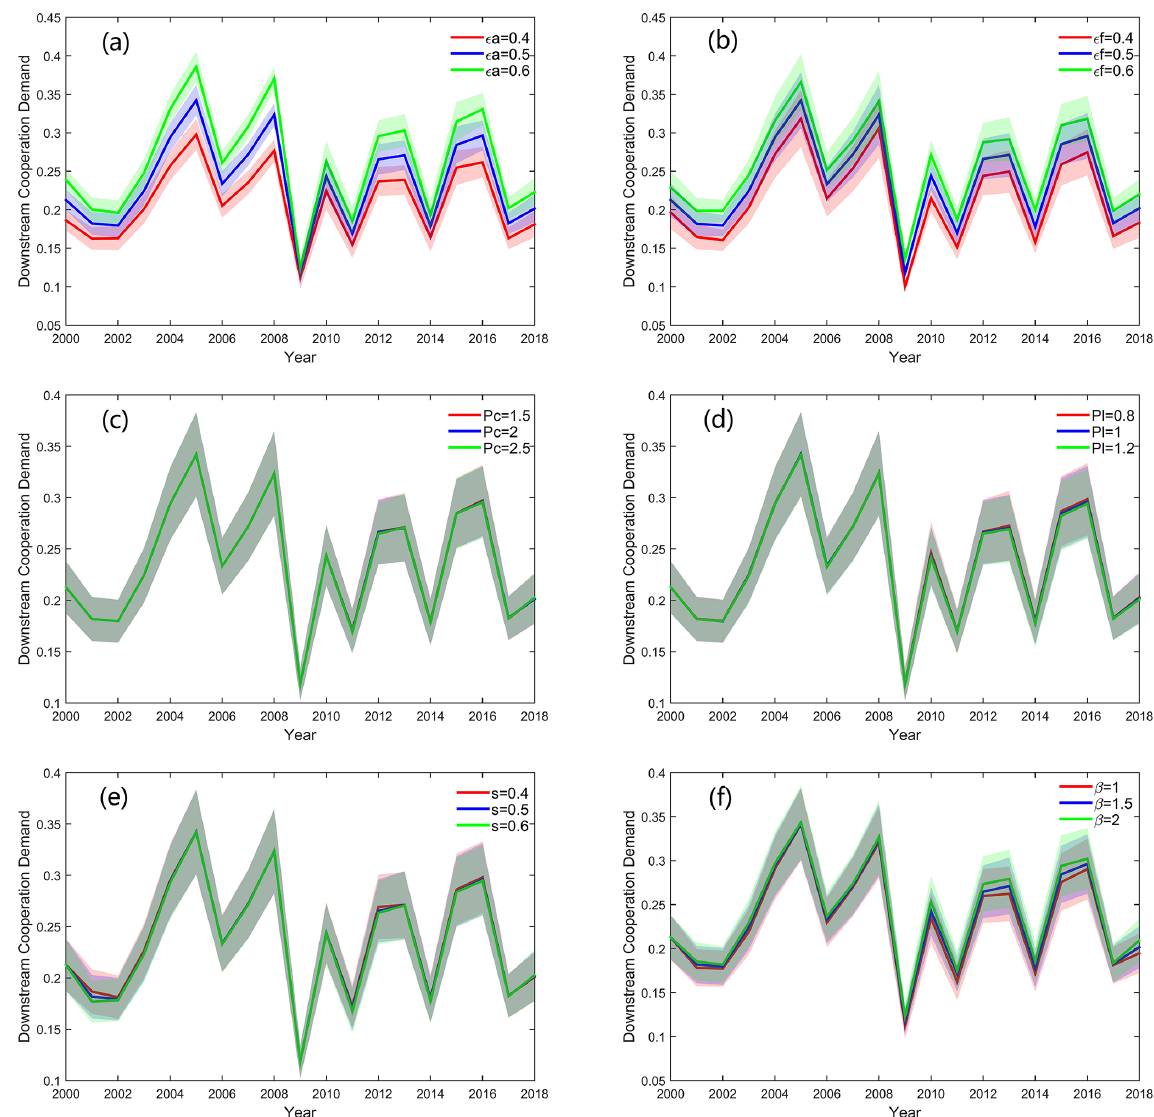
Figure 12. Uncertainty analysis of critical parameters in the socio-hydrological model. (a) Sensitivity of agriculture loss. (b) Sensitivity of fishery loss. (c) China political factor. (d) Laos political factor. (e) Responsive change rate. (f) Shape